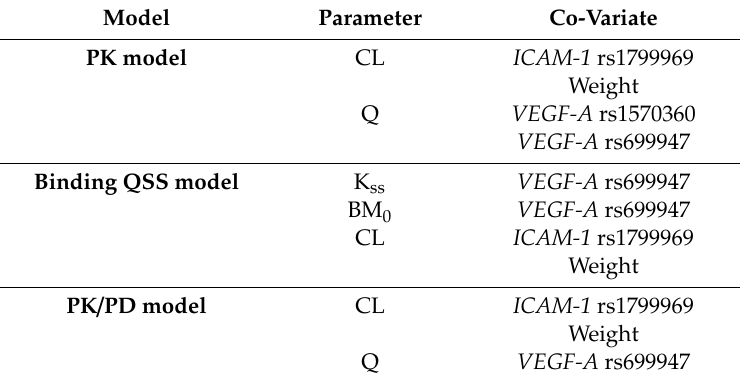
Table 4. Significant co-variate e ff ects observed in this